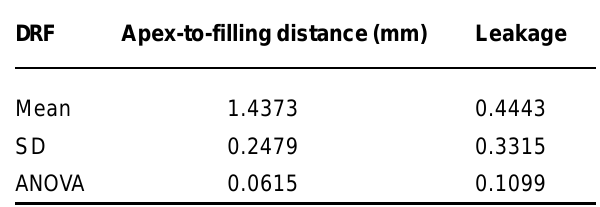
TABLE 2- Apex-to-filling distance (mm) and leakage extent (mm) in the disrupted-reinstrumented-filled (DRF) group